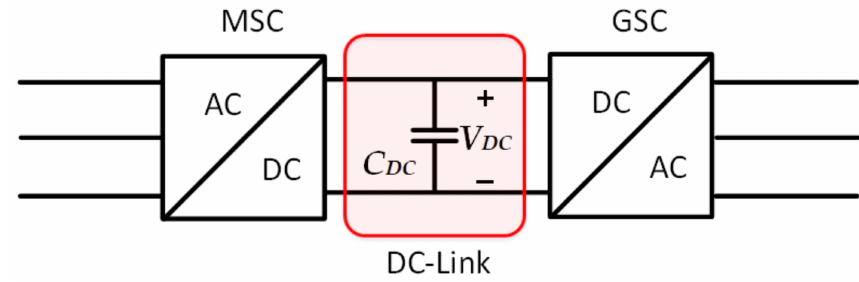
Figure 8. DC-link